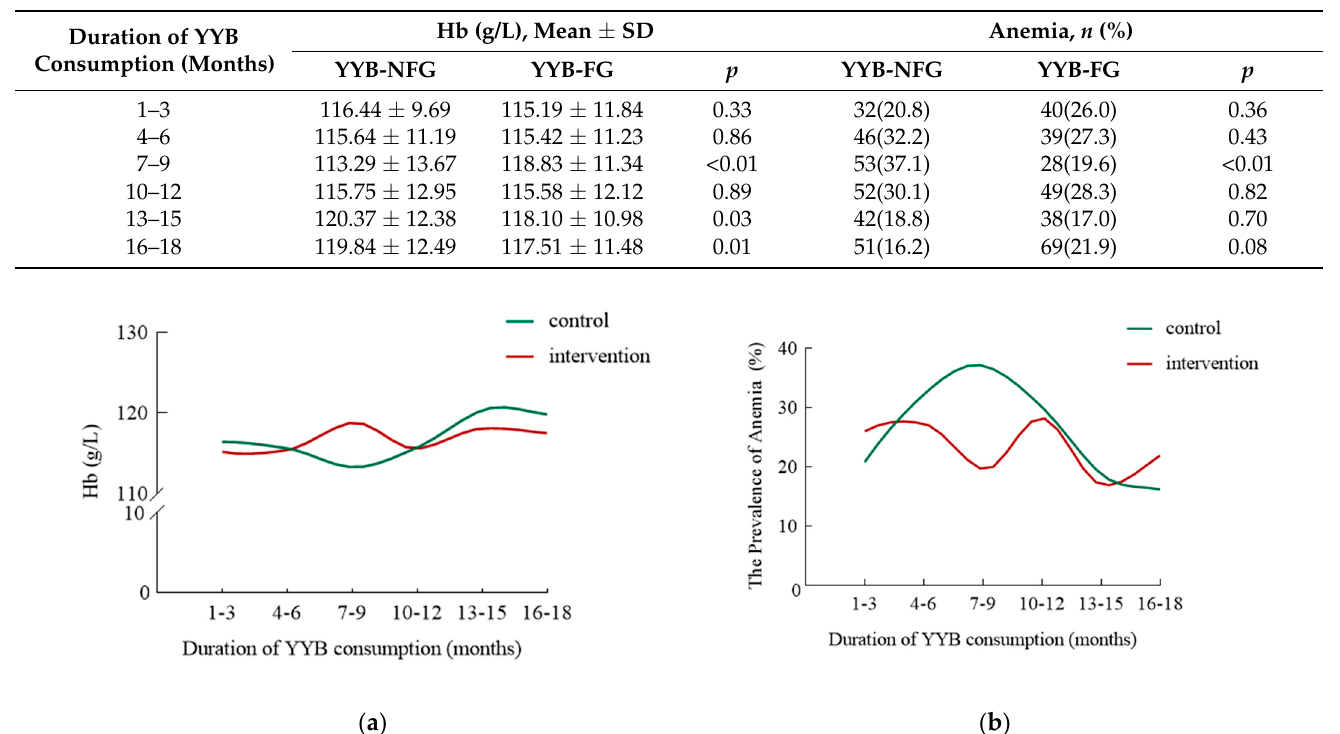
Table 2. Hb levels and anemia prevalence of IYC with different duration of YYB consumption.